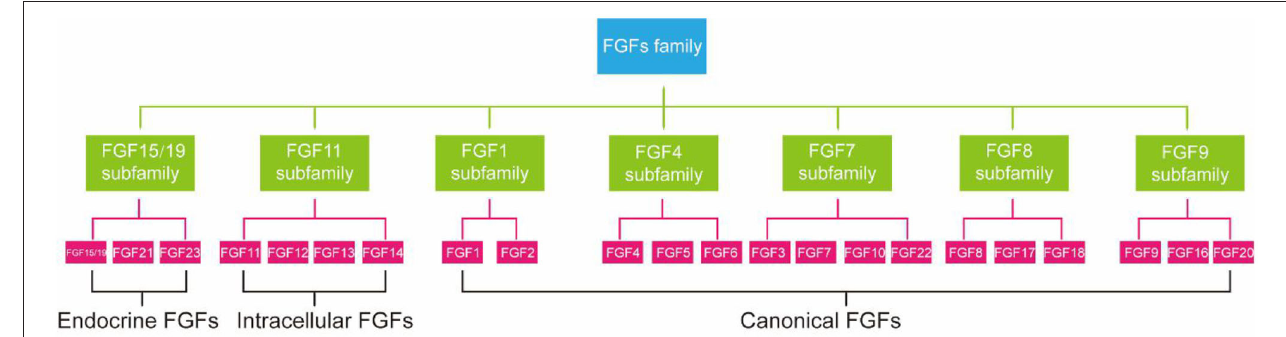
FIGURE 1 | Subfamilies of FGFs confirmed by phylogenetic